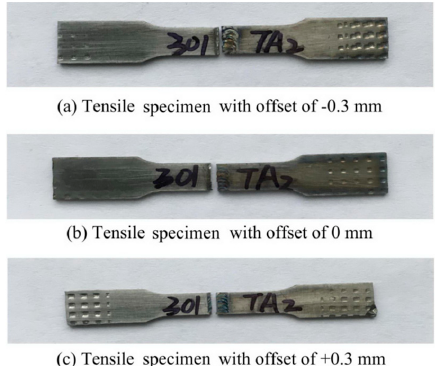
Figure 8. Dimension of tensile specimens.